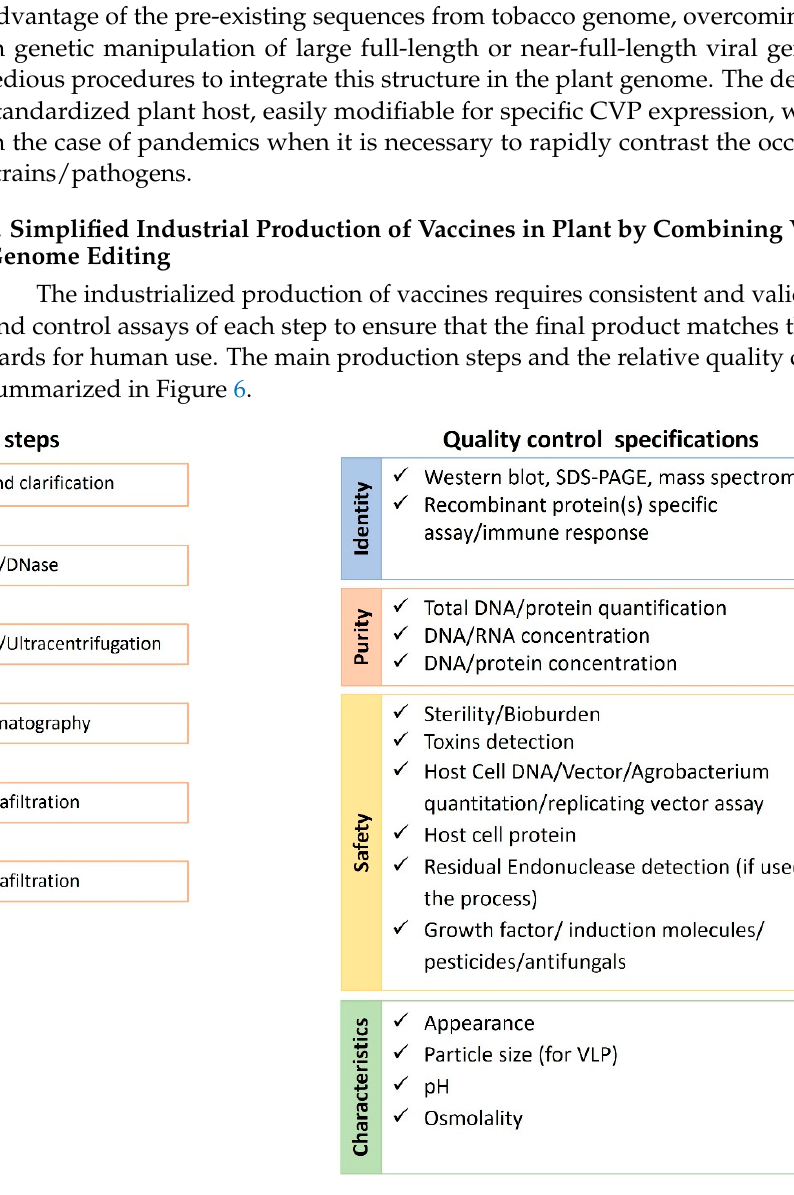
Figure 6. Summary of the production steps and quality control specification of industrial vaccines production.